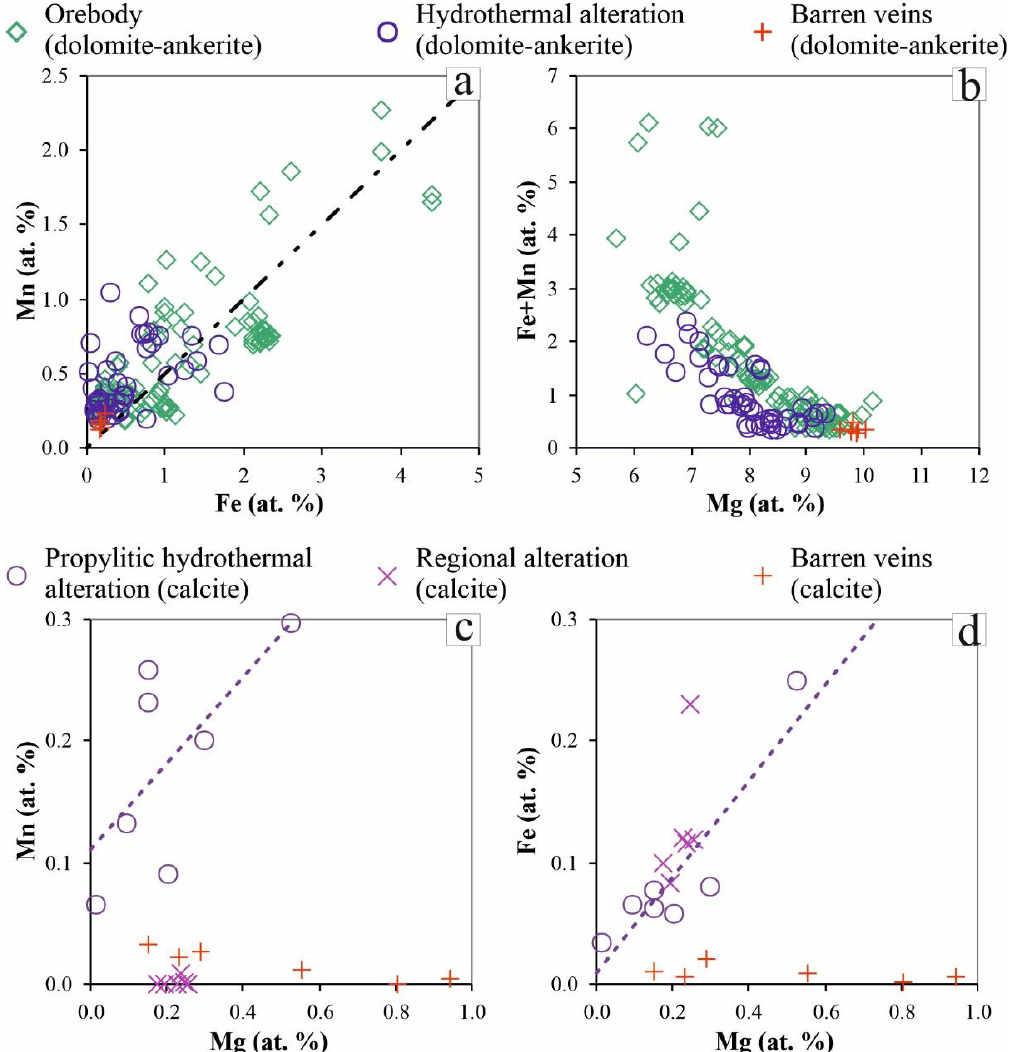
Figure 5. Composition of carbonates from Palai-Islica area (SE Spain): ( a ) Fe vs. Mn and ( b ) Mg vs. Fe+Mn in dolomite/ankerite: orebody, hydrothermal alteration, and barren veins in the volcanic rocks of the Cabo de Gata-Cartagena volcanic belt belonging to a regional alteration. The dotted line marks in ( a ) a Fe:Mn relation of 2:1. ( c ) Mg vs. Mn and ( d ) Mg vs. Fe in calcite: propylitic hydrothermal alteration, regional alteration in the volcanic rocks of the Cabo de Gata volcanic belt, and barren veins in the volcanic rocks of the Cabo de Gata volcanic belt. The dotted colored lines mark, respectively, in ( c ) and ( d ) the correlation between Mg and Mn (r 2 = 0.46) and Mg and Fe (r 2 = 0.85) in calcite from the propylitic hydrothermal alteration.